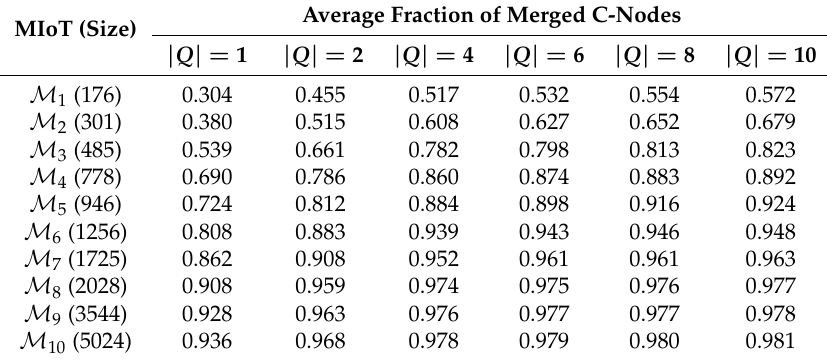
Table 5. Average fraction of merged c-nodes against the size of MIoTs and queries used to generate the virtual IoTs (supervised approach).